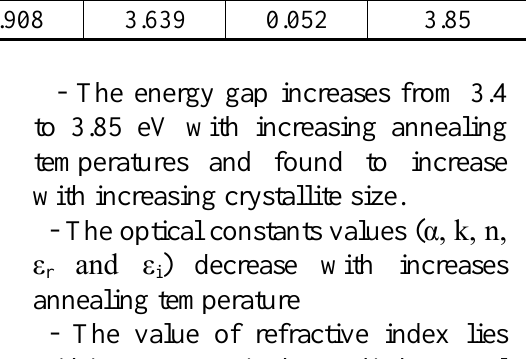
Table 4: The values of T%, α, K, n, εr, εi, Eg at different annealing temperature at λ=500 nm T ( ᵒ a